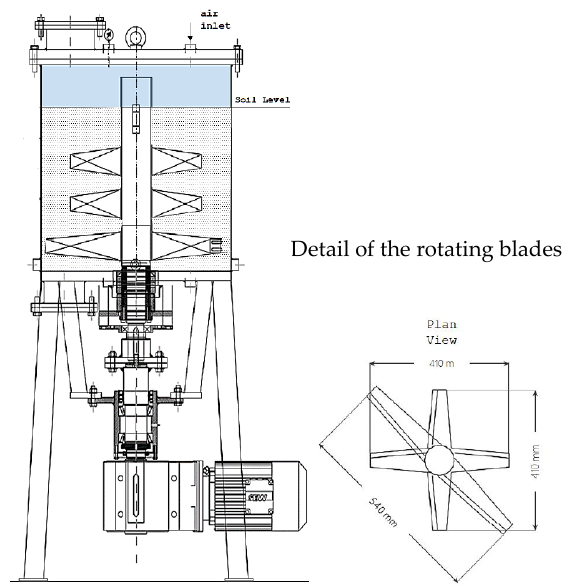
Figure 1. Rotational mixer test device scheme. Modified from Martinelli [18].